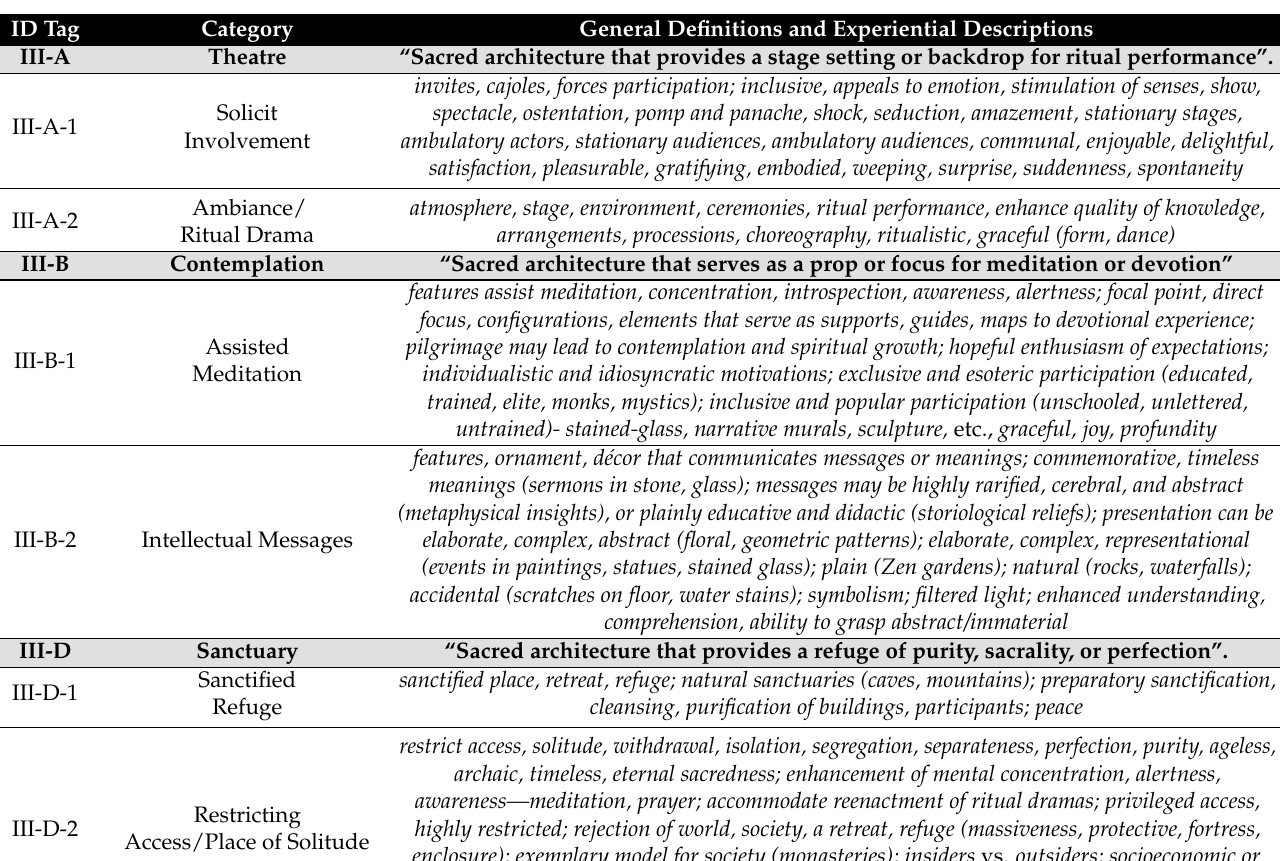
Table 1. Experiential descriptor words for Jones’ ritual contexts and their respective subcategories.